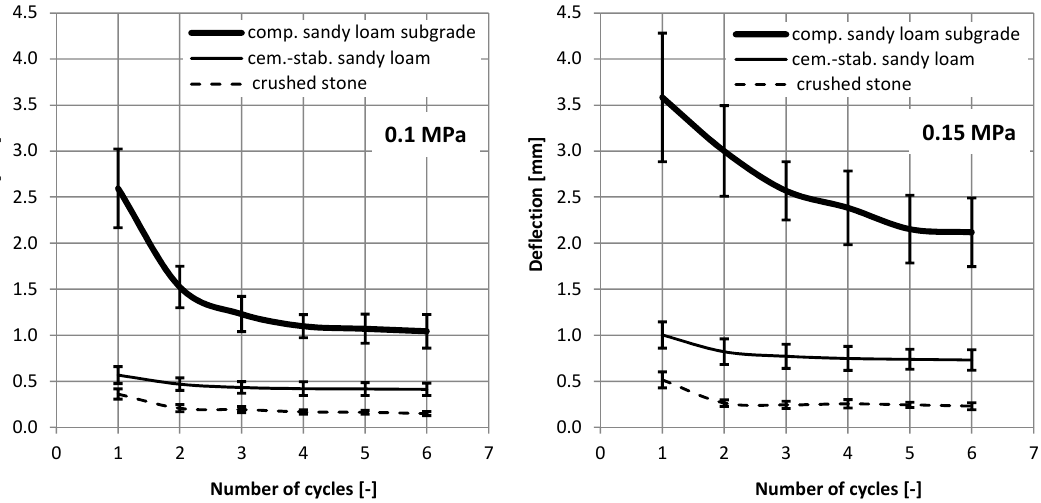
Figure 2. Vertical displacements as a function of the number of load cycles, depending on the type of the tested subgrade at the load of 0.1 and 0.15